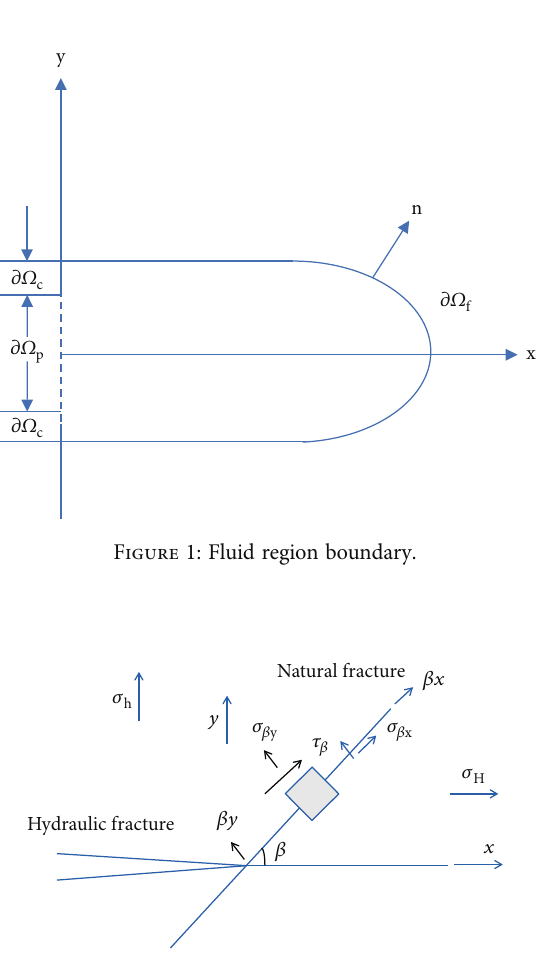
Figure 2: Interaction between HFs and